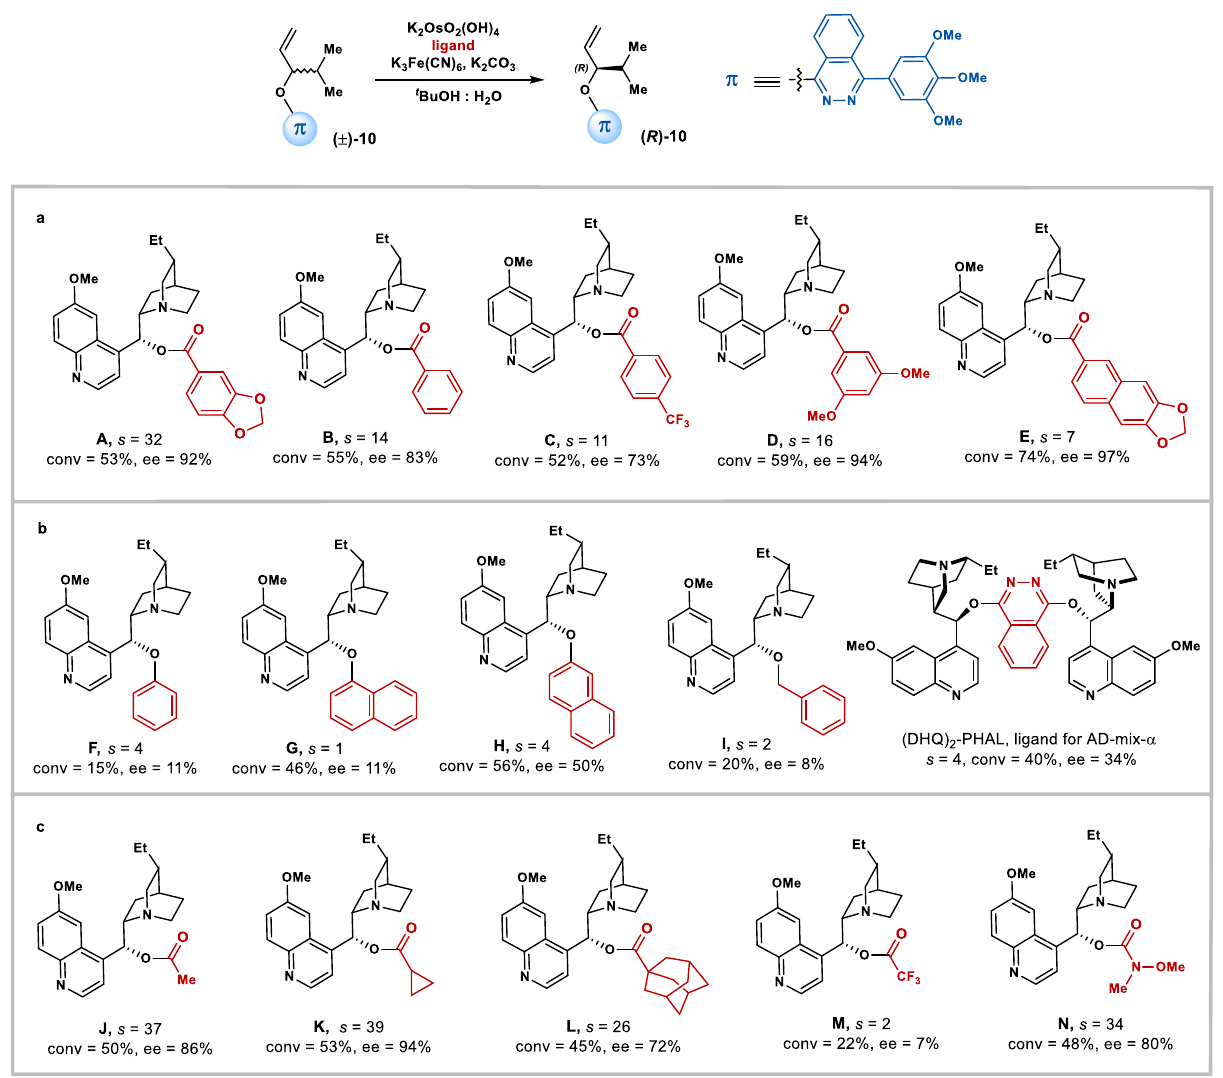
Fig. 3 Exploring the nature of the non-covalent π -interaction. a The π -component at C9 of the cinchona alkaloid ligands with benzoate moiety. b The π - component at C9 of the cinchona alkaloid ligands with aromatic moiety. c The π -component at C9 of the cinchona alkaloid ligands only with carbonyl moiety. General condition: K 2 OsO 2 (OH) 4 (0.4 mol%), K 3 Fe(CN) 6 (3.0 equiv), K 2 CO 3 (3.0 equiv), ligand (1.0 mol%), and (±)- 10 (0.1 mmol) in 1.0 mL t